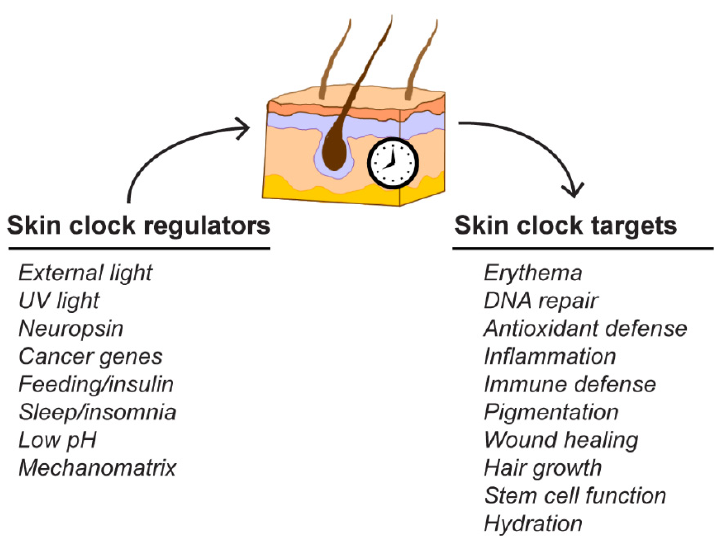
Figure 4. Regulators and targets of the circadian clock in the skin. Multiple factors influence circadian rhythmicity in the skin. The clock subsequently regulates many aspects of skin physiology. Light is considered to the be major signal that entrains the body’s circadian clock.